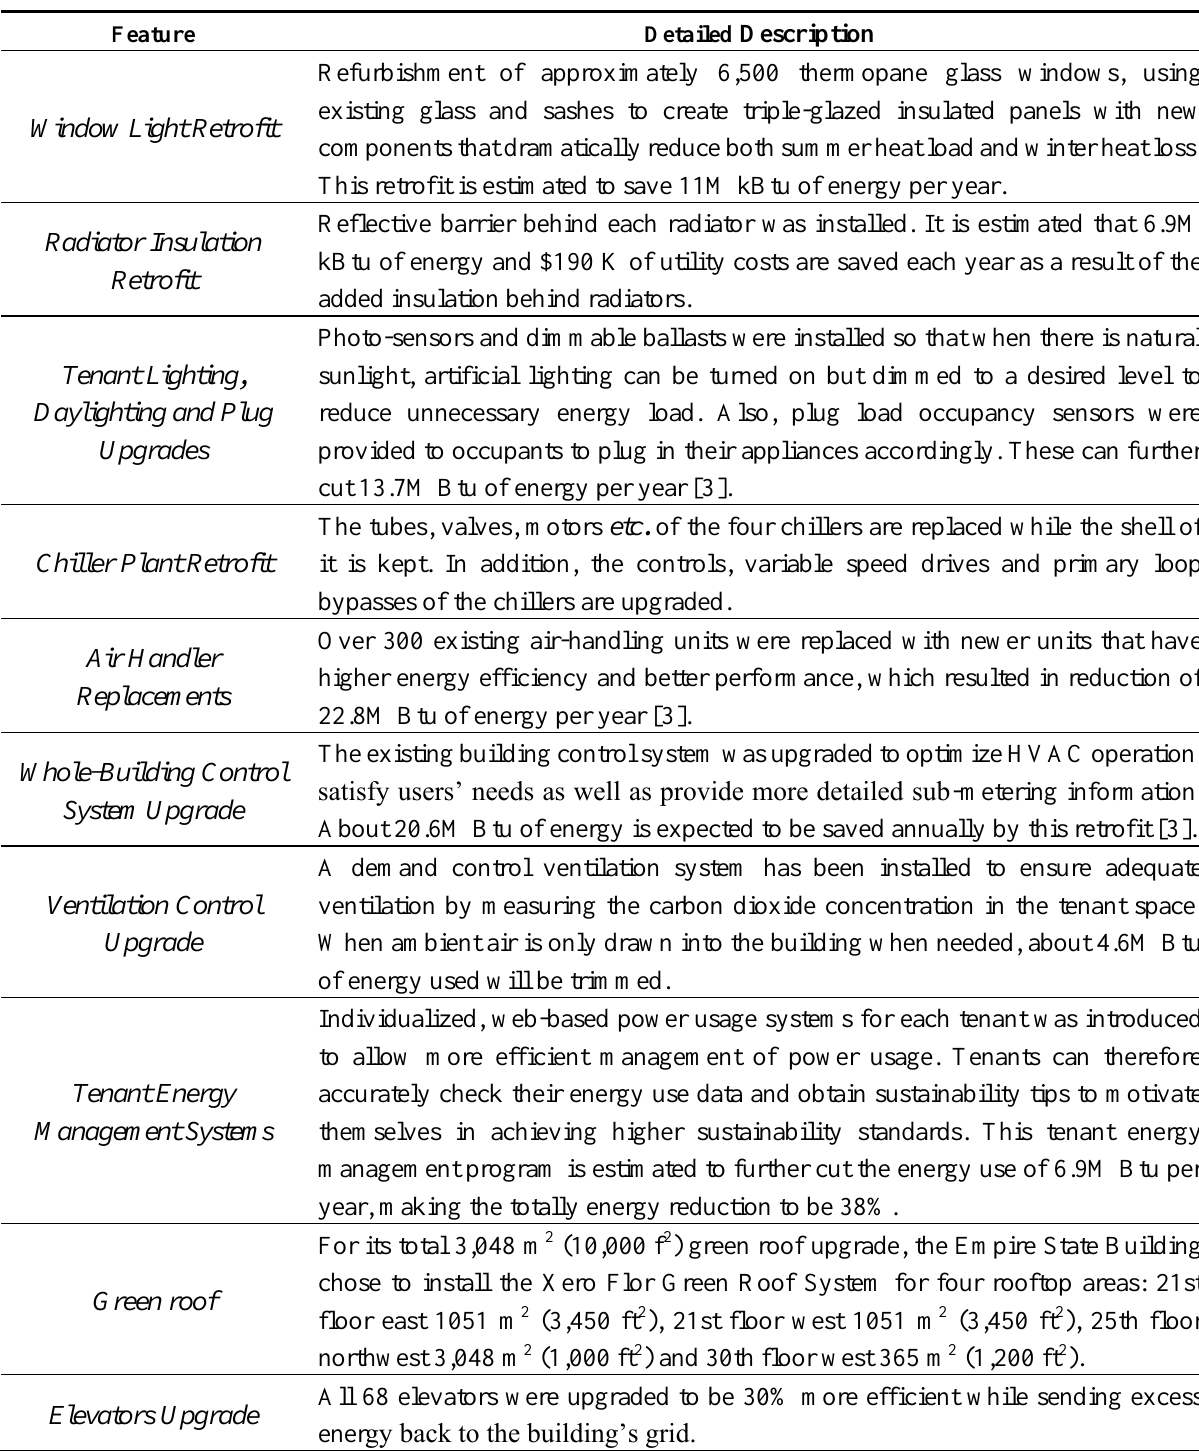
Table 2. Summary of key upgraded features of the Empire State Building